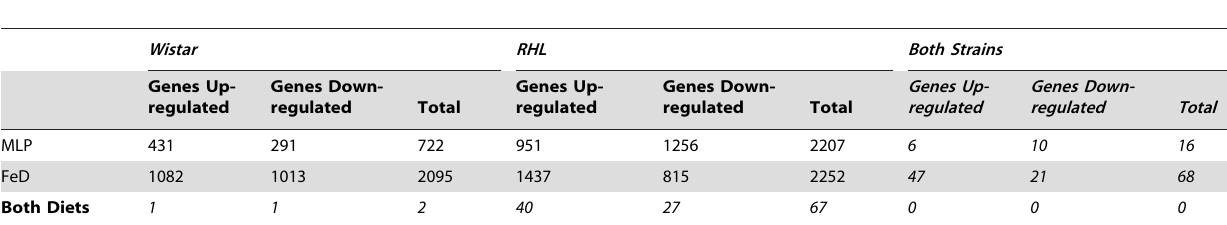
Table 2. Number of genes up- and down-regulated with each dietary insult compared to its control, in each strain of rat (n=8 animals per group; RHL – Rowett hooded Lister, MLP – maternal low protein, FeD – iron deficient).